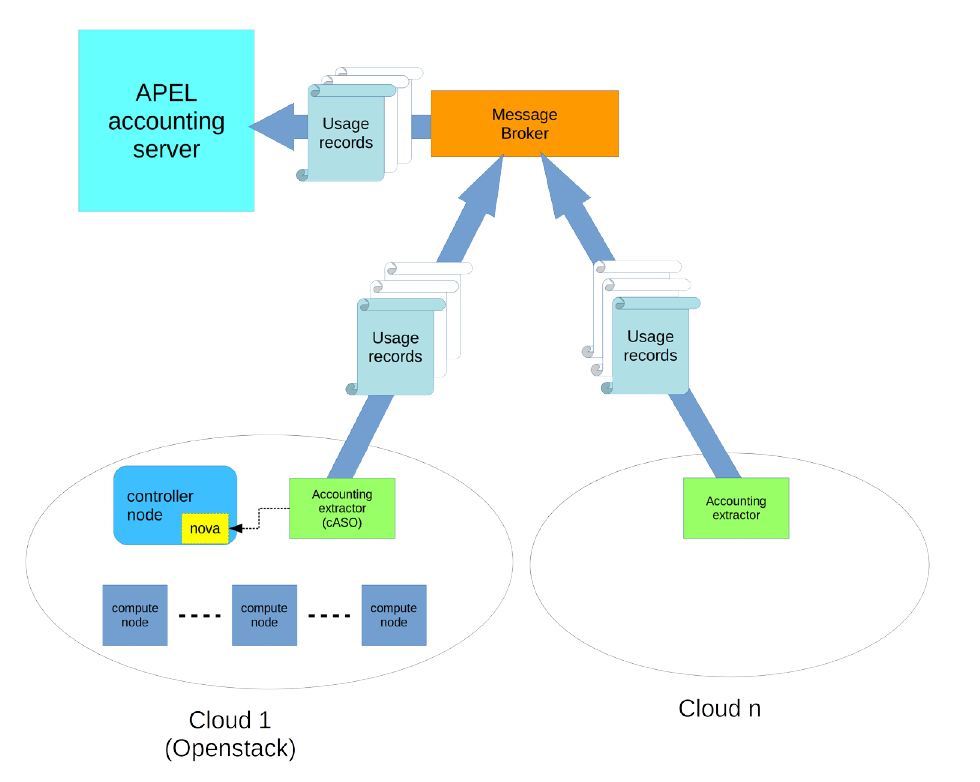
Figure 2. Architecture of EGI FedCloud accounting